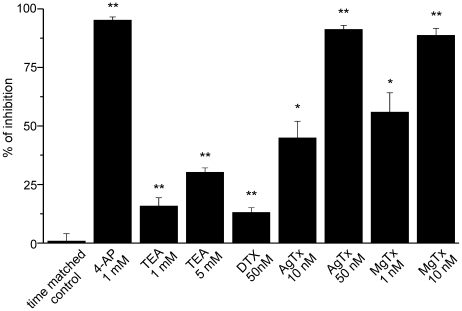
Summary of the effects induced by the different drugs tested on the outward rectifying potassium current evoked by a voltage step from −70 to +30 mV.The histogram represents the average of the leak subtracted current after drug application and normalized to its pre-drug value. The “time matched control” bar corresponds to experiments in which the current was measured during 10 to 15 minutes without any drug application to control for the absence of any significant run-down of the current. Statistical tests were done on raw data (paired t test, **p<0.01; the number of tested cells for each condition is that given in the legends of figures 3 and 4).